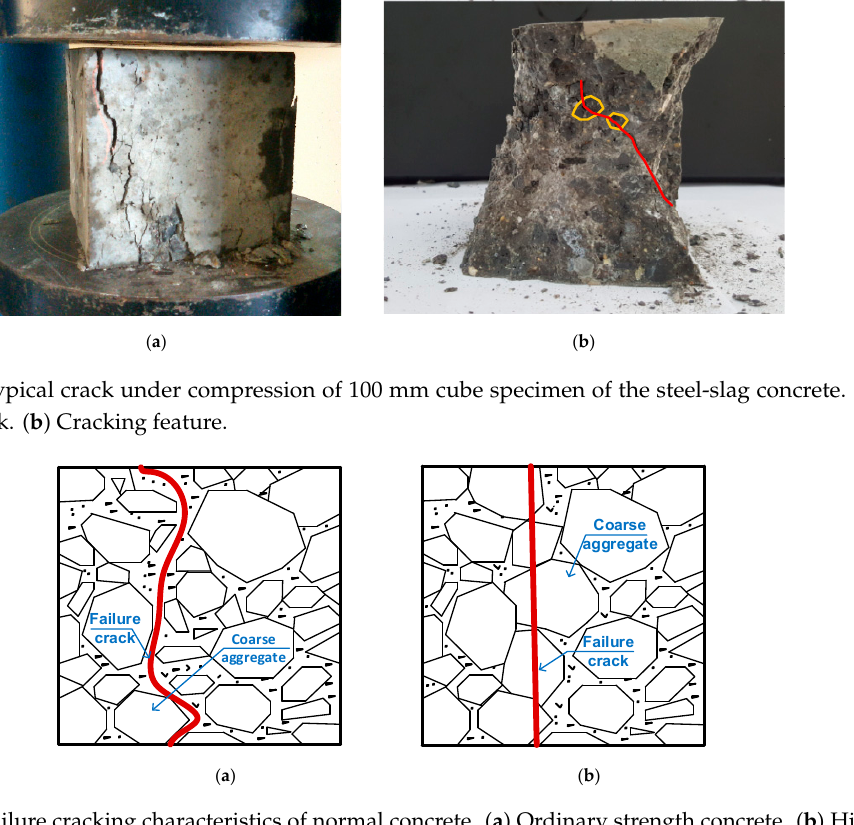
Figure 6. Failure cracking characteristics of normal concrete. ( a ) Ordinary strength concrete. ( b ) High strength concrete.